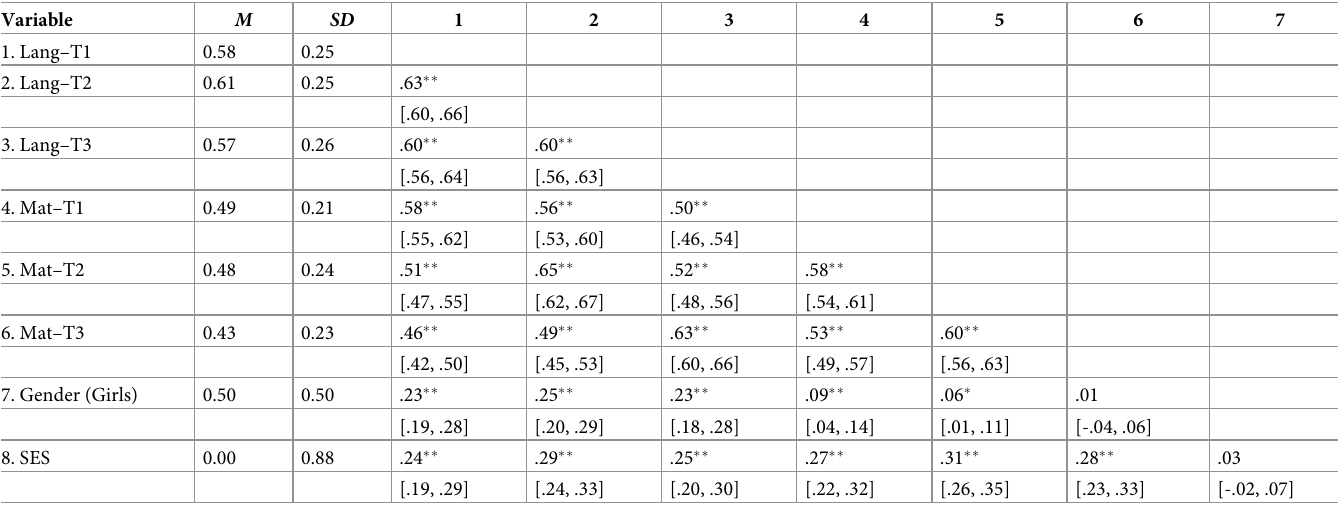
Note . M and SD are used to represent mean and standard deviation, respectively. Lang–results in language (three waves), Mat–results in mathematics (three waves), SES–socioeconomic status. Values in square brackets indicate the 95% confidence interval for each correlation. The confidence interval is a plausible range of population correlations that could have caused the sample correlation (Cumming, 2014). � indicates p < .05. �� indicates p <